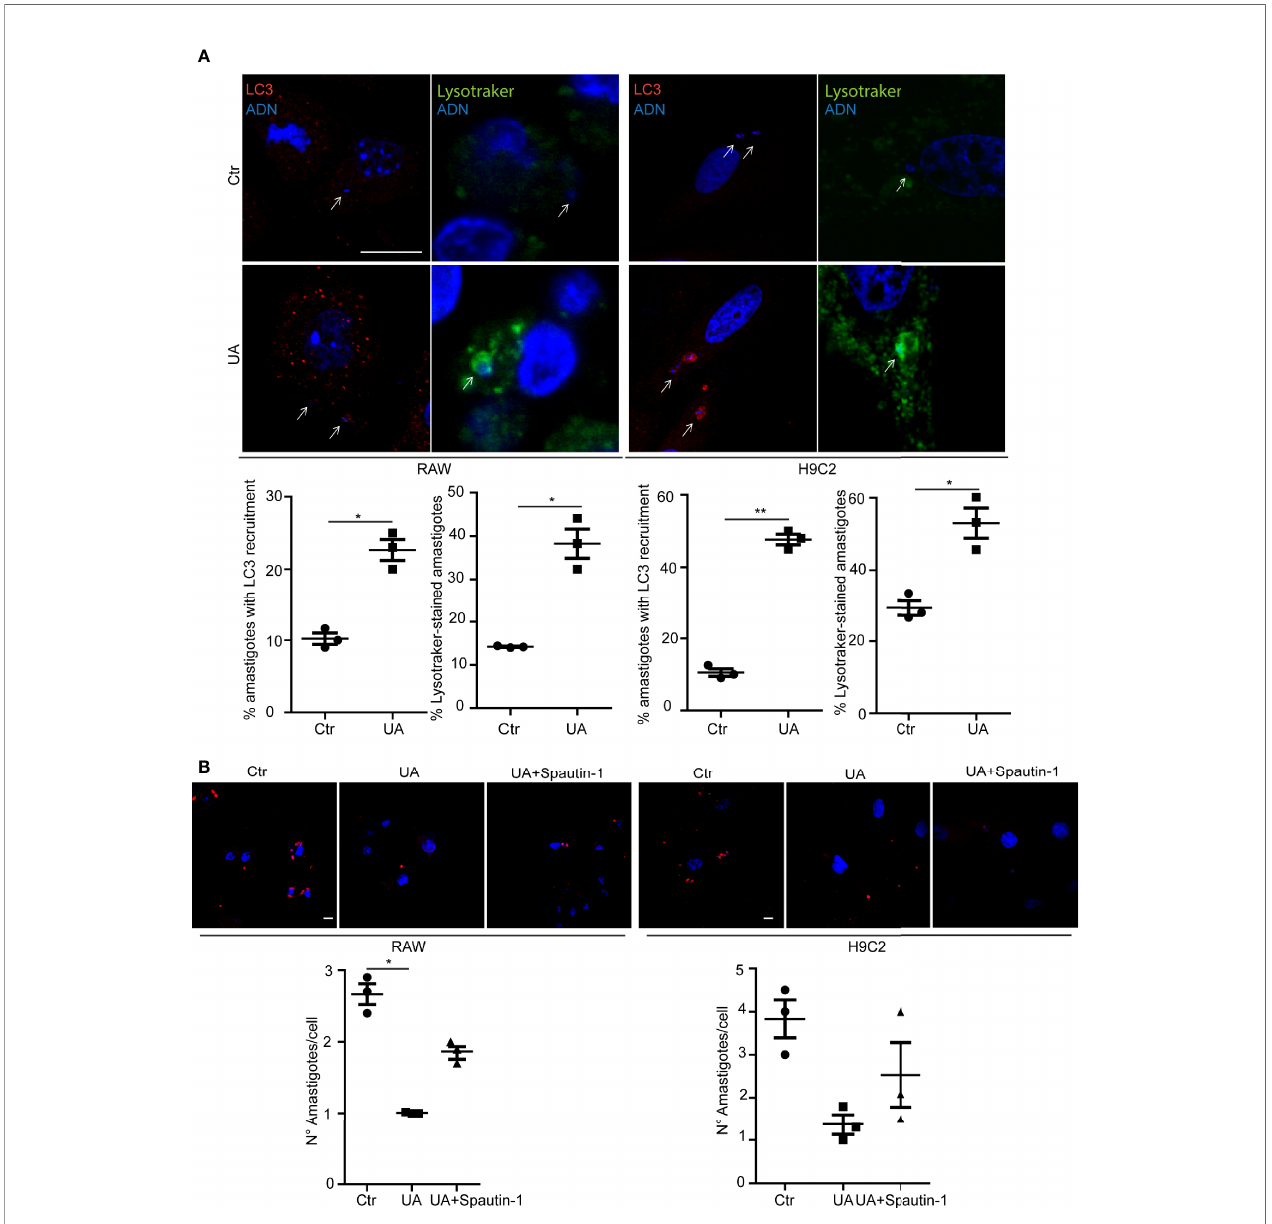
FIGURE 3 | Study of the Trypanosoma cruzi xenophagy. RAW macrophages or H9C2 cells infected with T. cruzi strain Y (MOI = 10) for 24 h and then treated for additional 2 or 24 h in different conditions. (A) RAW macrophages or H9C2 cells infected with T. cruzi Y strain for 24 h and then treated for an additional 2 h under different conditions. Confocal images depicting recruitment of LC3 (red) detected by indirect immuno fl uorescence or LysoTracker (Green) to T. cruzi amastigotes. Scale bars, 10 m m. White arrows point to amastigotes. The graphs show the percentage of the mean ± SD of three independent experiments on the recruitment of LC3 or LysoTracker in the different conditions. **p < 0.01. Tukey ’ s test. (B) RAW macrophages or H9C2 cells infected with T. cruzi Y strain (MOI = 10) for 24 h and then treated for an additional 24 h in different conditions, control, 10 µM of UA, or 10 µM of UA with Spautin-1. Confocal images show T. cruzi amastigotes (red) under different conditions. The graphs represent the mean ± SEM of the number of amastigotes per cell under the different conditions. MOI, multiplicity of